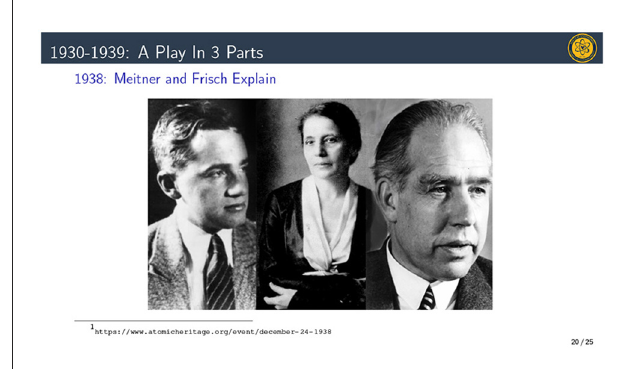
FIGURE8 Important female players in twentieth-century